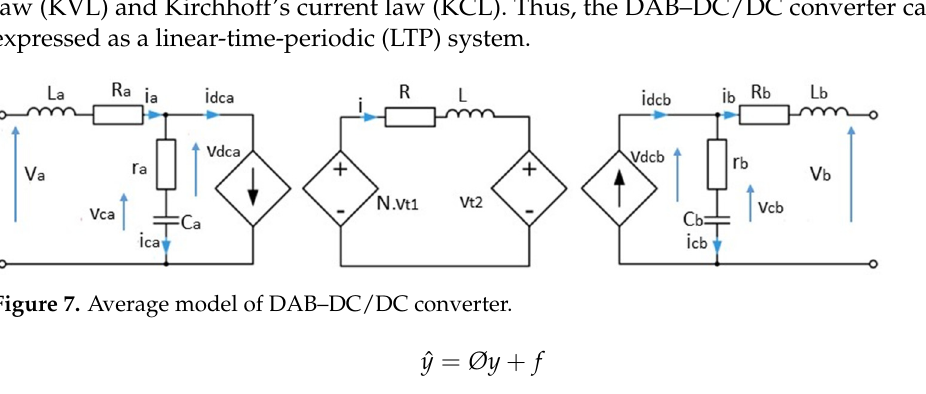
Figure 6. Block representation of proposed fast current controller for SPS DAB–DC/DC converter.